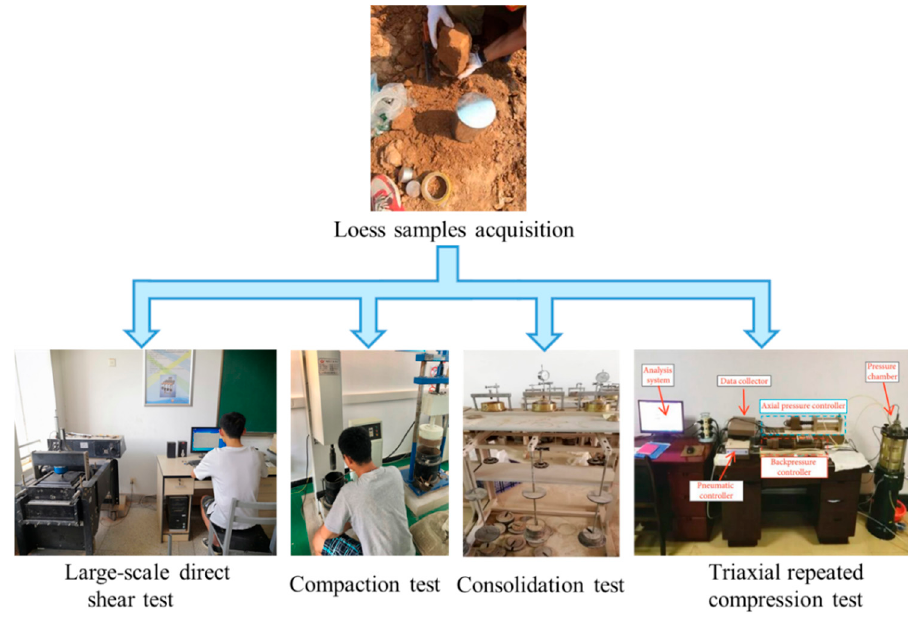
Figure 3. Physical properties test of loess filler.